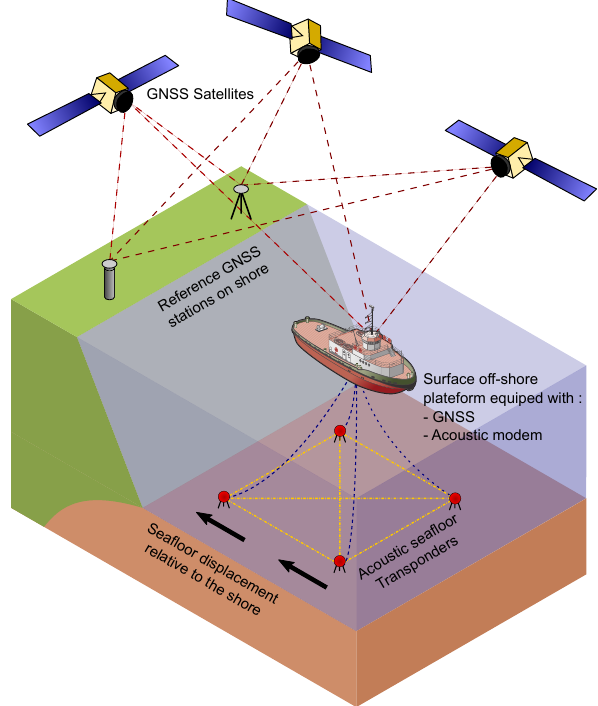
Figure 1. Schematic representation of a GNSS-A experiment. The acquisition protocol can be divided in two segments: (1) a surface segment aiming at accurately positioning an acoustic modem mounted on a surface platform (e.g., research vessel, buoy, or wave-glider) with GNSS (differential or Precise Point Positioning); and (2) an underwater segment with acoustic transponders permanently installed on the seafloor and serving as benchmarks, which are ranged from the acoustic modem on the surface platform. The absolute positions of the transponders are derived by combining the GNSS position of the acoustic modem with the transponder positions relative to the